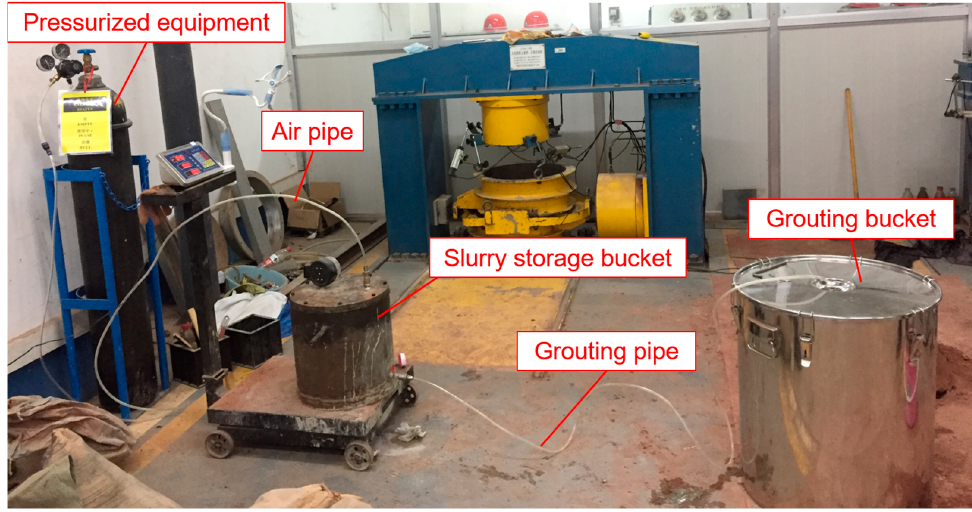
Figure 3. Diagram of the test device.